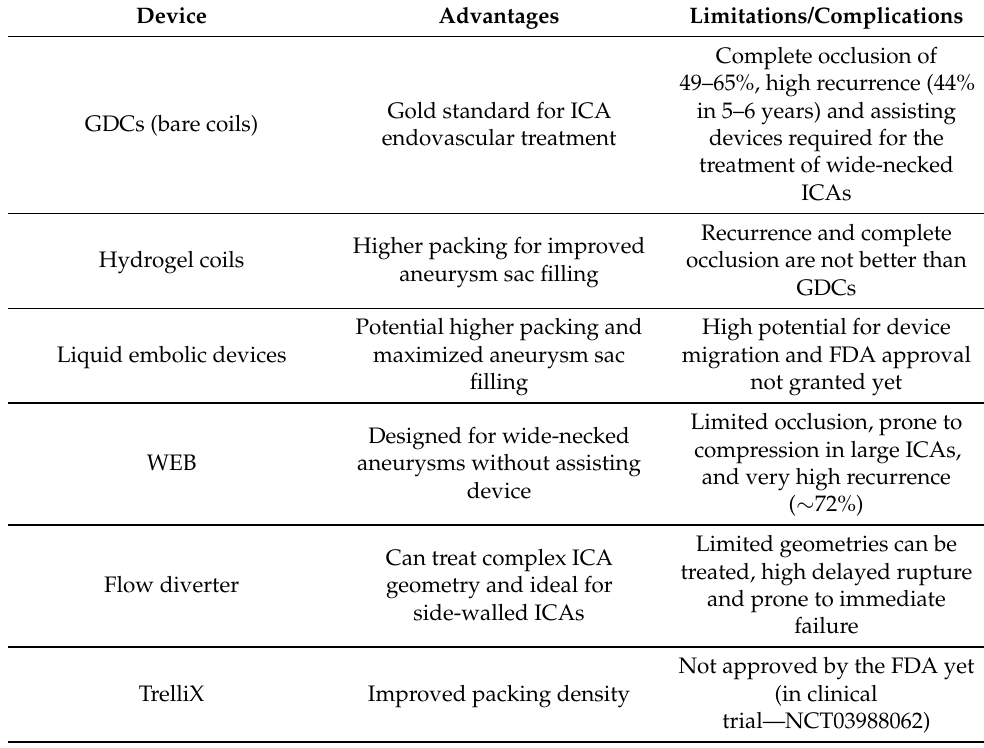
Table 1. Current endovascular devices for the treatment of ICAs and their advantages and